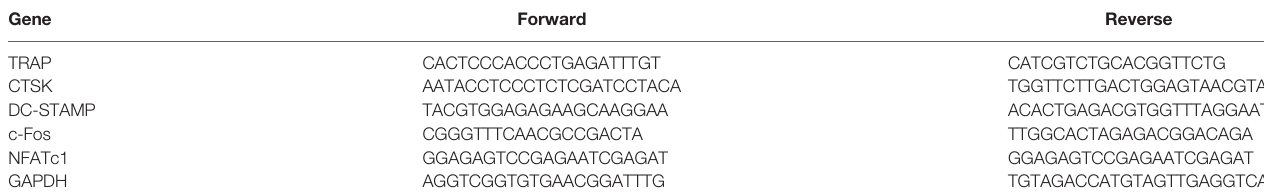
TABLE 1 | Primers used for quantitative PCR (5 ′ – 3 ′ sequence). Gene Forward Reverse